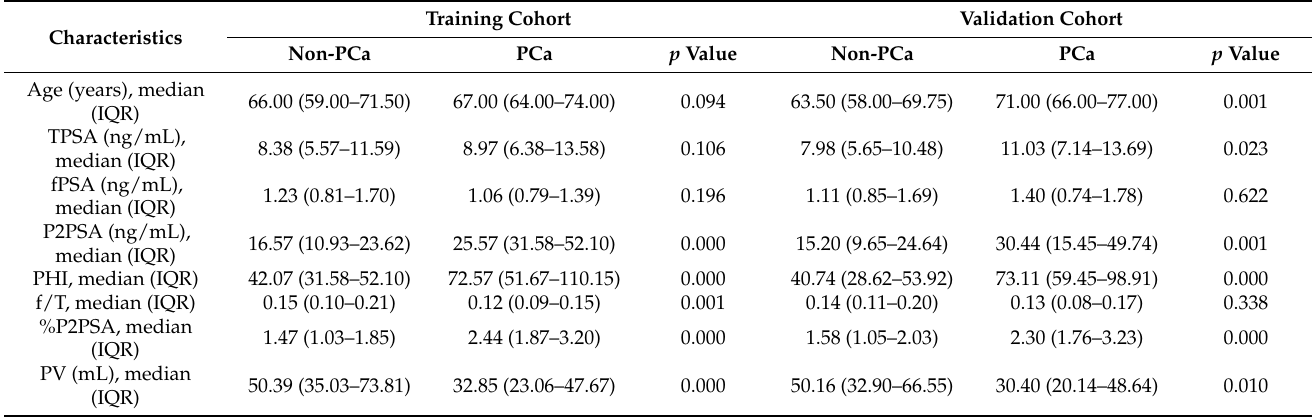
Table 2. Patient characteristics in training and validation cohorts with and without